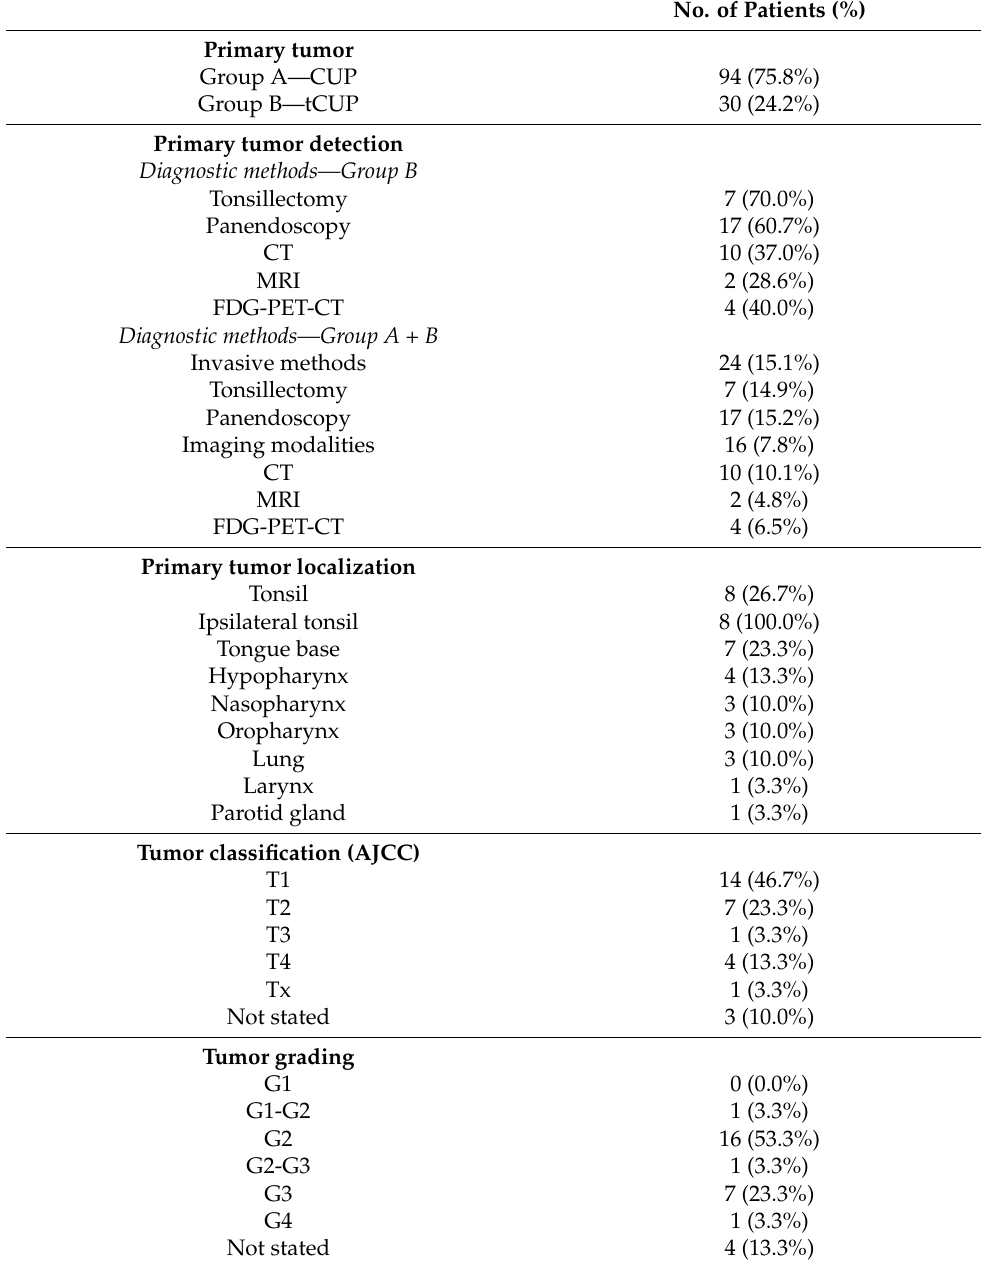
Table 3. Primary tumor and diagnostic